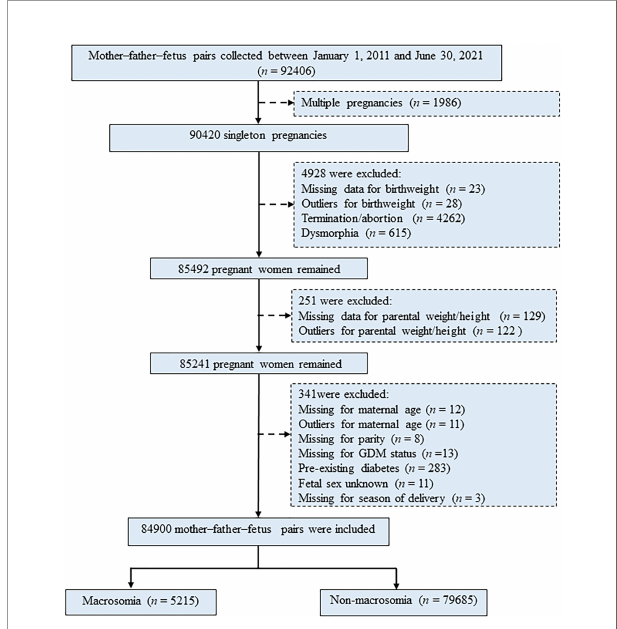
FIGURE 1 | Flowchart of the selection of study participants. GDM, gestational diabetes